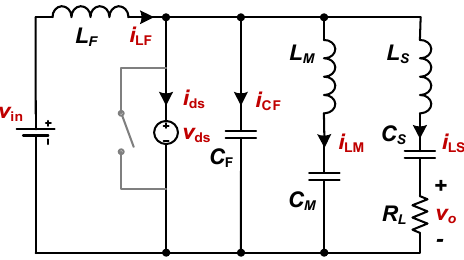
Figure 3. Voltage source equivalent model of a VHF class Ф 2 inverter.